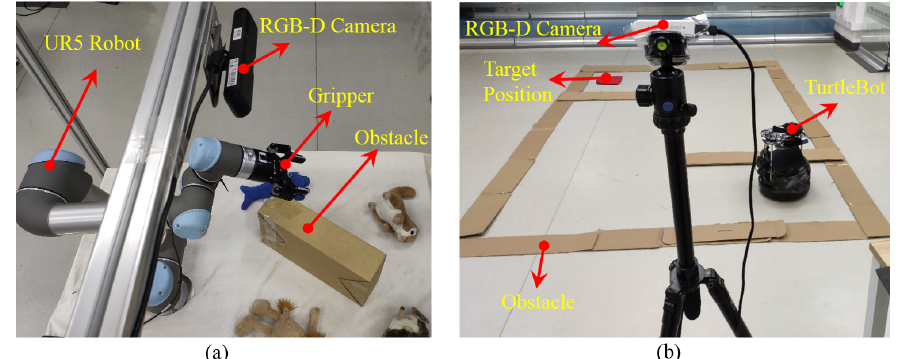
Figure 4. Two designated tasks are evaluated for our method. ( a ) Manipulation task. A policy is trained to control a UR5 robot gripper to reach the target object in 3D space and avoid obstacles (yellow box). ( b ) Navigation task. Learning a policy navigates the TurtleBot to the target position without obstacle